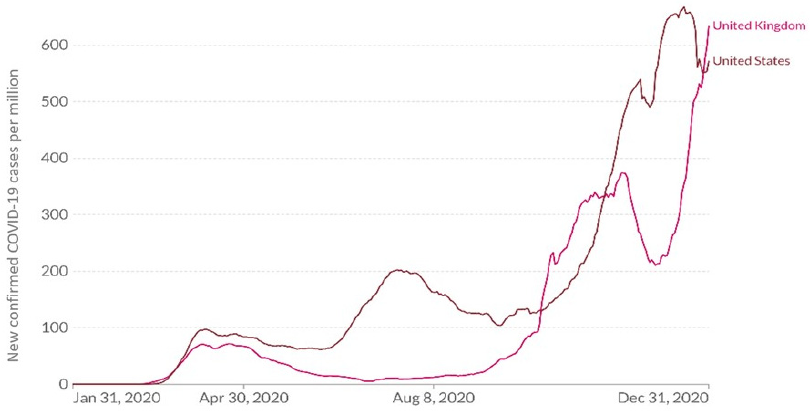
Figure 2. Daily new confirmed COVID-19 cases (per million) in the US and UK in 2020